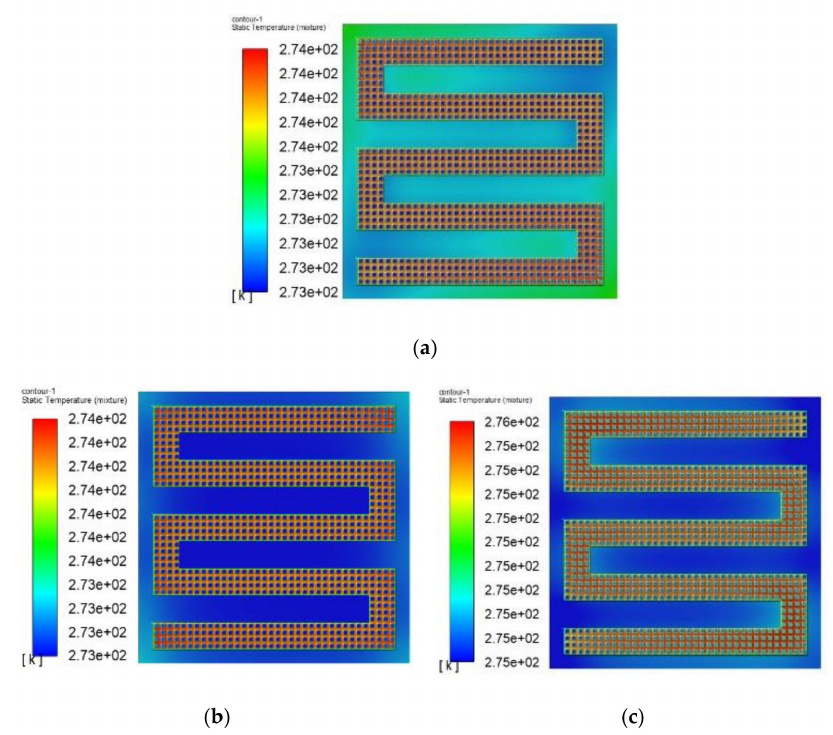
Figure 25. The fuel cell temperature contours with pore diameter = 0.6 mm at di ff erent times; ( a ) t = 30 s, ( b ) t = 38 s, ( c ) t = 46 s.